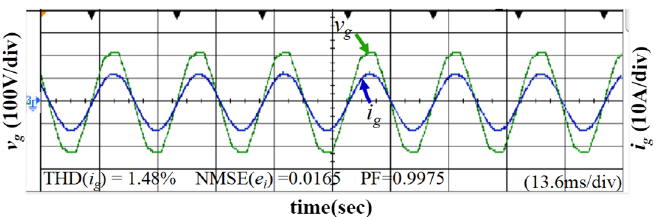
Figure 11. Experimental results of grid-connected inverter with inductance ( L f = 1.5 mH).